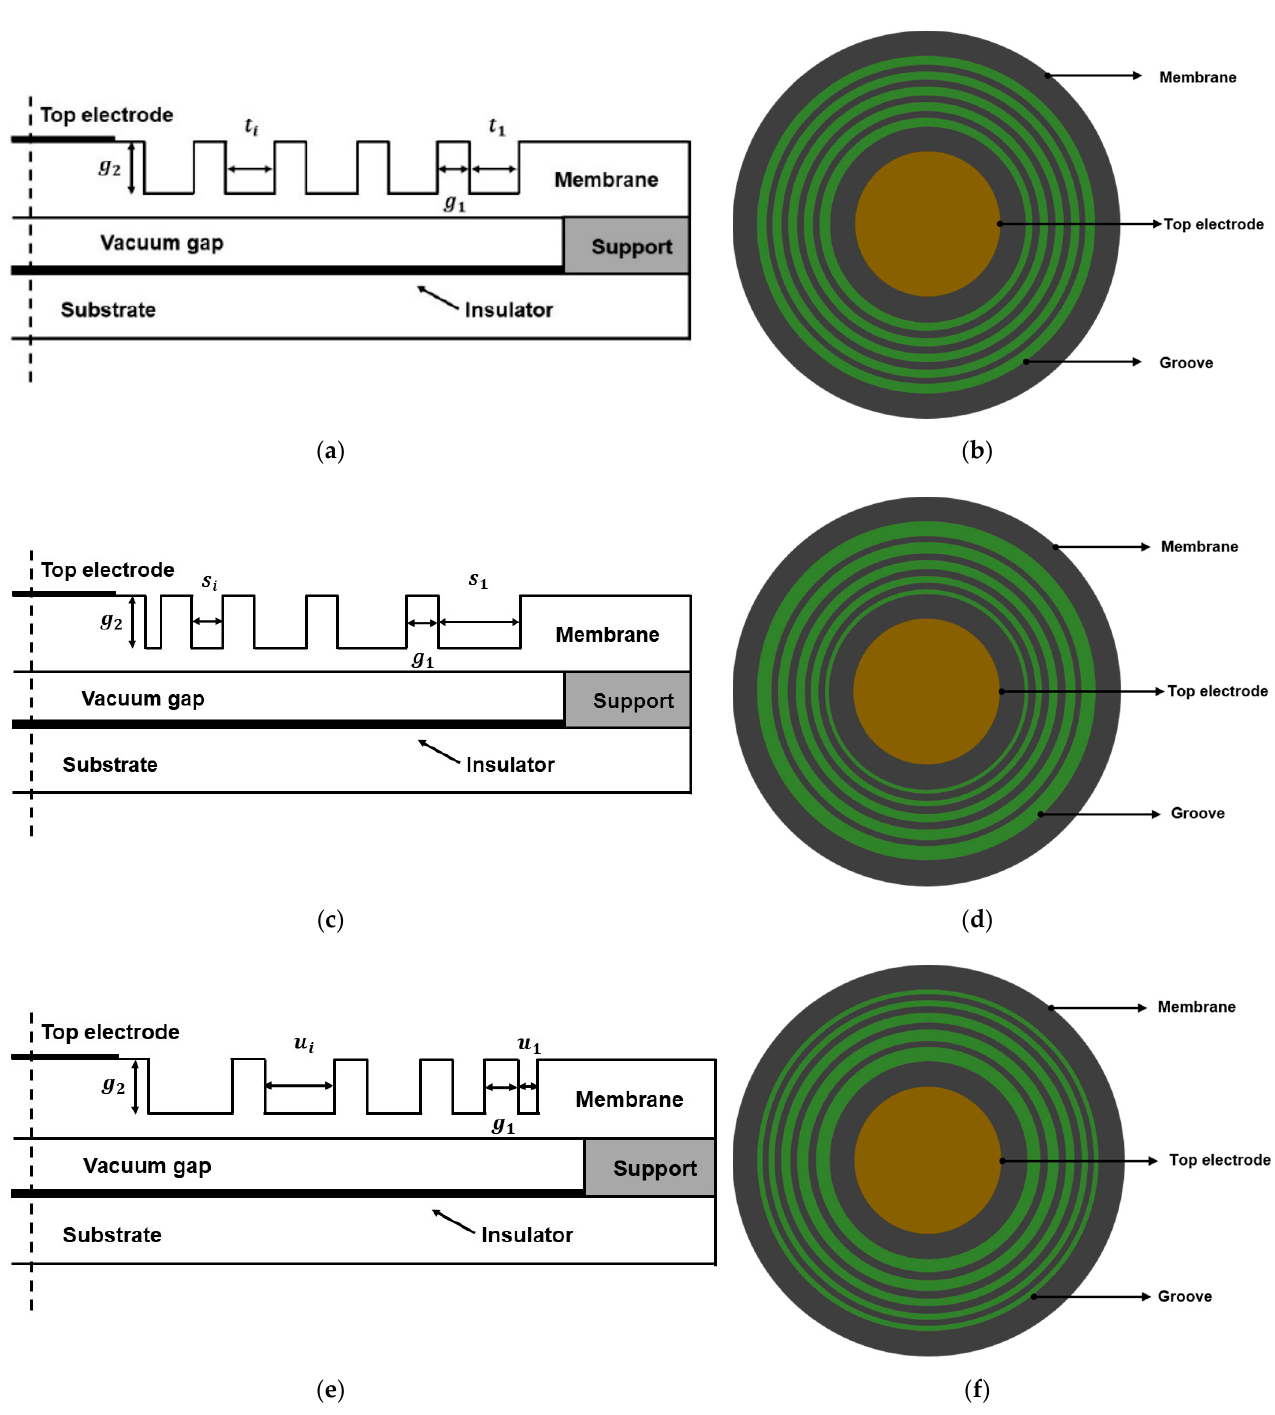
Figure 3. Schematic diagrams of different CMUT designs: C3, C4, and C5: ( a ) front view of C3; ( b ) top view of C3; ( c ) front view of C4; ( d ) top view of C4; ( e ) front view of C5; ( f ) top view of C5.